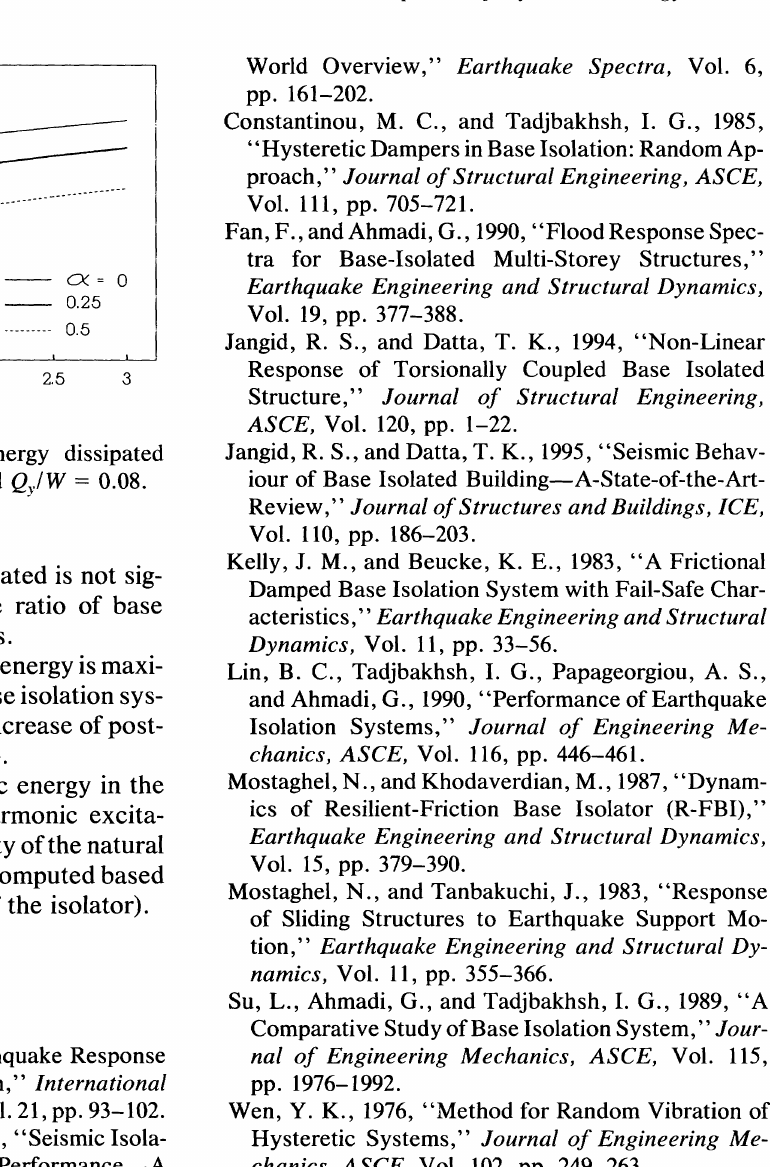
FIGURE U Plot of hysteretic energy dissipated against mass ratio mb1m; T = 1 sand QylW =